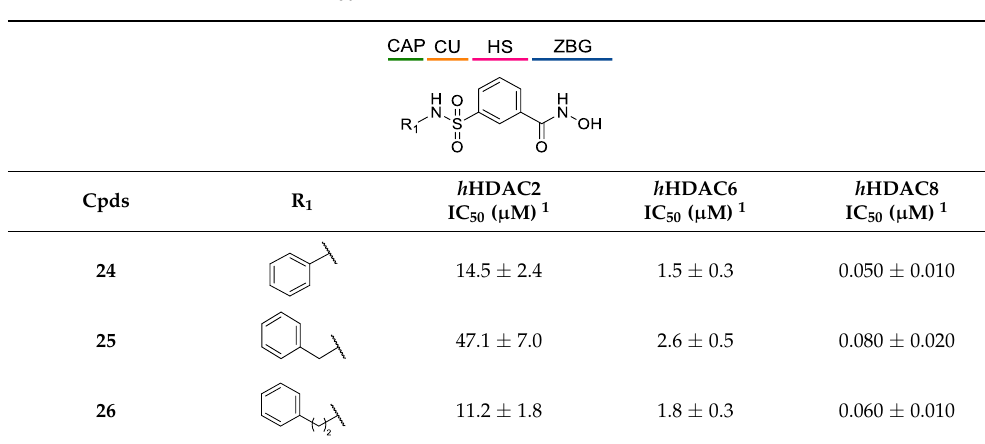
Table 4. General structure and IC 50 values of 24 , 25 , and 26 [34].